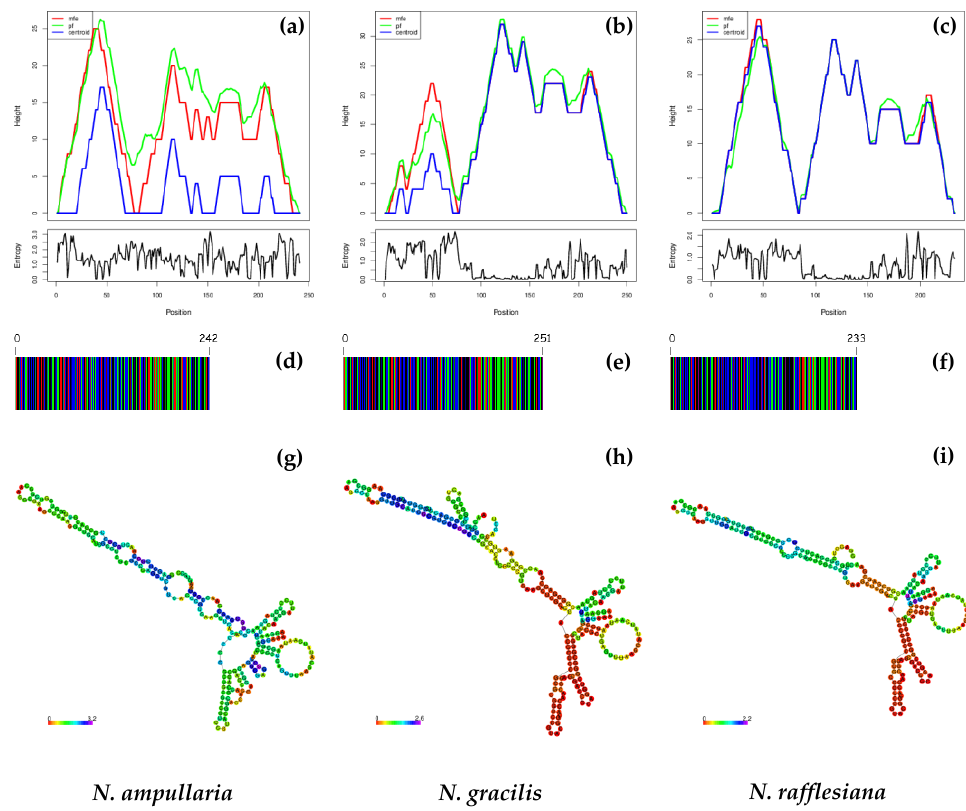
Figure 6. The variations observed in the predicted minimum free energy (MFE) ( a – c ), DNA barcodes ( d – f ), and secondary structures of the ITS2 region for the three Nepenthes species ( g-i ).